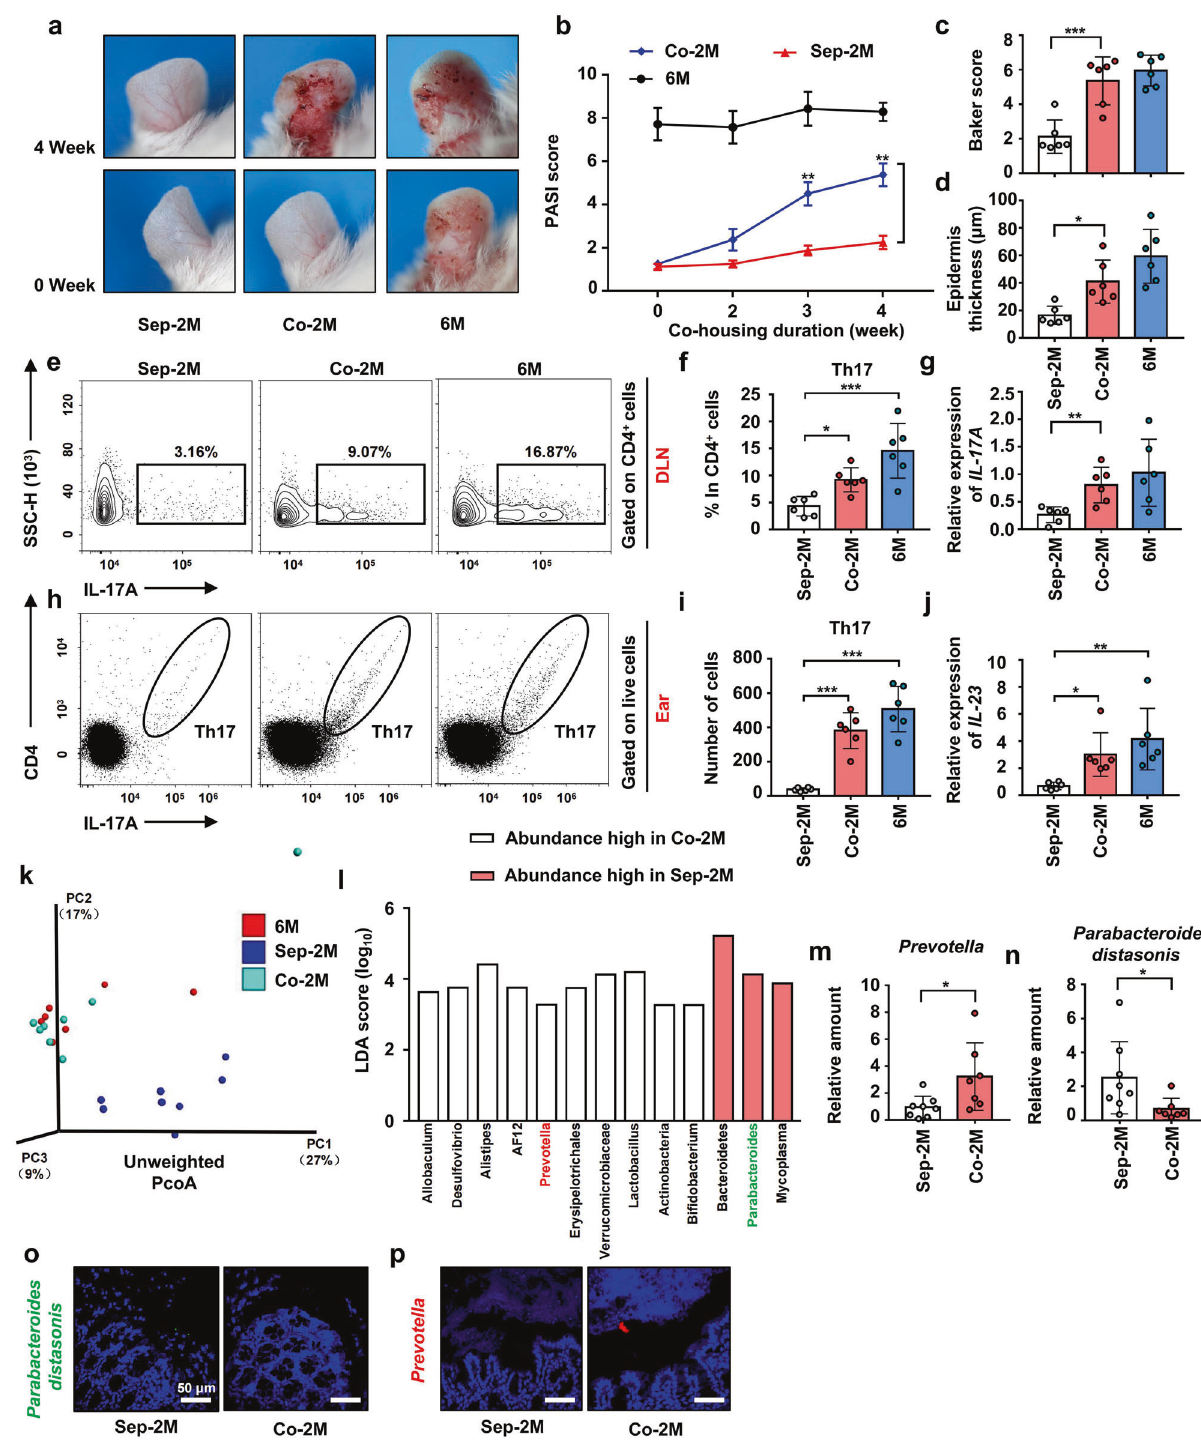
Fig. 2 Co-housing with 6 M mice exacerbated psoriasis-like skin phenotype in and changed the intestinal microbiota composition of, 2 M mice. a Macroscopic characteristics of the ears of Sep-2M Co-2M and 6 M mice in 0 week and 4 weeks. b PASI score of ears in Sep-2M Co-2M and 6 M mice from 0 week to 4 weeks. c Pathological score of ear sections using the Baker scoring system. d Average epidermal thickness. e Analysis of Th17 cells (CD4 + IL-17 + ) by fl ow cytometry in DLNs. f Percentage of Th17 cells in CD4 + cells. g Relative mRNA expression of IL- 17A in the ears. h Analysis of Th17 cells (CD4 + IL-17 + ) by fl ow cytometry in ears. i Number of Th17 cells in ears. j Relative mRNA expression of IL-23 in the ears. k PcoA of unweighted UniFrac distance based on 16s rDNA pro fi ling of feces from Sep-2M Co-2M and 6 M mice. l Results of LEfSe analysis showing bacteria, at the lowest taxonomic level, that were signi fi cantly different in abundance in Sep-2M and Co-2M mice. m , n Fecal contents of Sep-2M and Co-2M mice were analyzed for Prevotella and Parabacteroides distasonis colonization by qPCR. o , p Representative fl uorescence in situ hybridization for Prevotella (Prv392) and Parabacteroides distasonis (PD) in the colon. Data presented as mean ± SD on relevant graphs. * P ≤ 0.05; ** P ≤ 0.01; *** P ≤ 0.005. A two-tailed Student ’ s t -test was used in ( m ) and ( n ), one-way ANOVA was used for comparing the rest of the groups. ( n = 6) in ( a – j ). Sep-2M ( n = 8), Co-2M ( n = 7) and 6 M ( n = 7) in ( g , h ). ( n = 6) in o , p Signal Transduction and Targeted Therapy (2023)